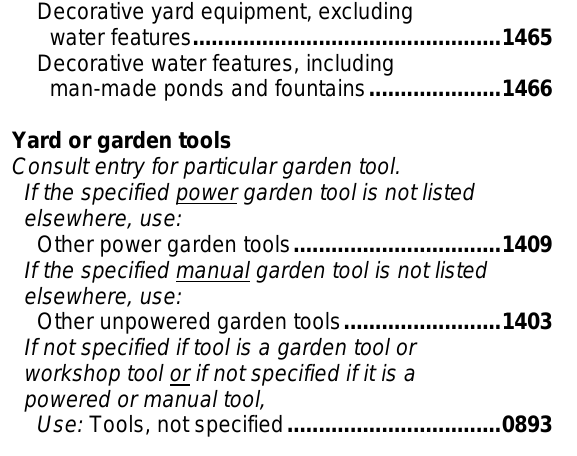
Yarn Use: Sewing basket articles (excl. scissors, pins, Yoga (activity or apparel, without equipment ) Use: Exercise (activity and apparel without equipment ; incl. aerobics, stretching, walking, Yoga balls Use: Exercise equipment (excl. weight Yoga equipment Use: Exercise equipment (excl.